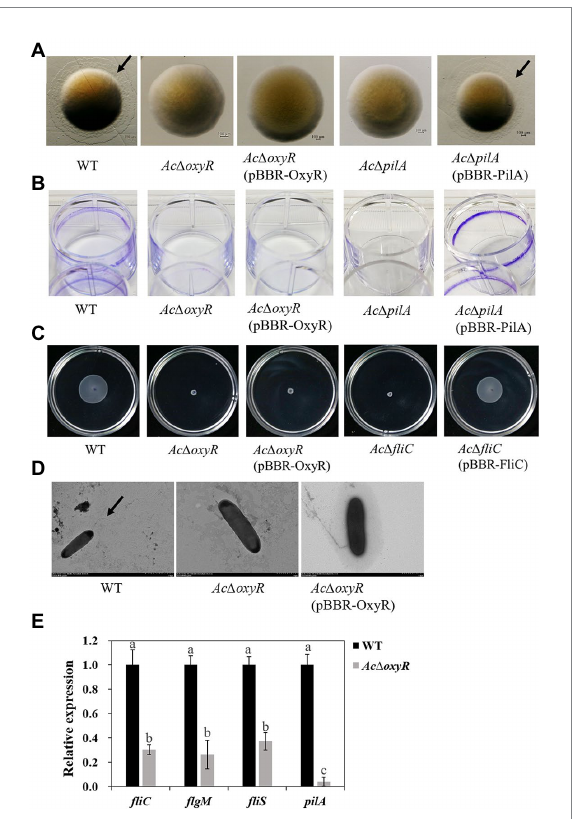
FIGURE 4 Role of oxyR in twitching motility, biofilm production, and swimming motility of A. citrulli . (A) Twitching motility of A. citrulli strains including A. citrulli wild-type (WT), Ac Δ oxyR , Ac Δ pilA, and complementation strains Ac Δ oxyR (pBBR-OxyR) and Ac Δ pilA (pBBR-PilA). Strains were painted on nutrient agar plates containing (B) Biofilm formation of A. citrulli strains including A. citrulli wild-type (WT), Ac Δ oxyR , Ac Δ pilA, and complementation strains Ac Δ